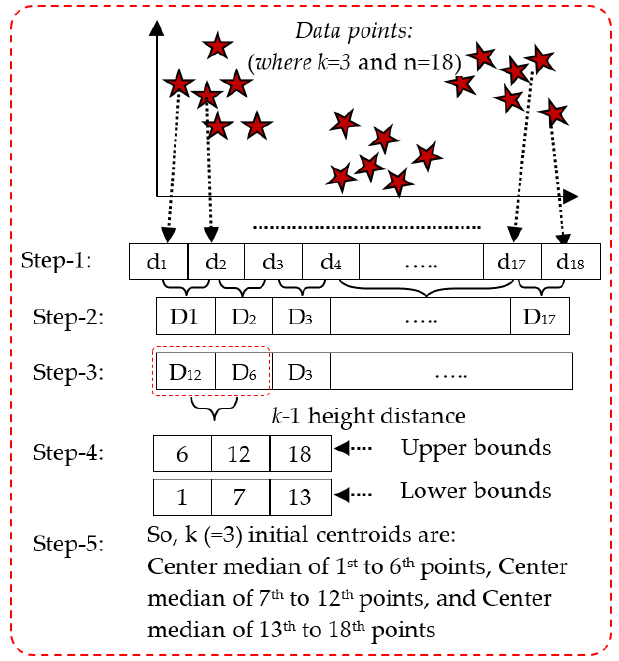
Figure 10. Initial centroids selection process with an example.